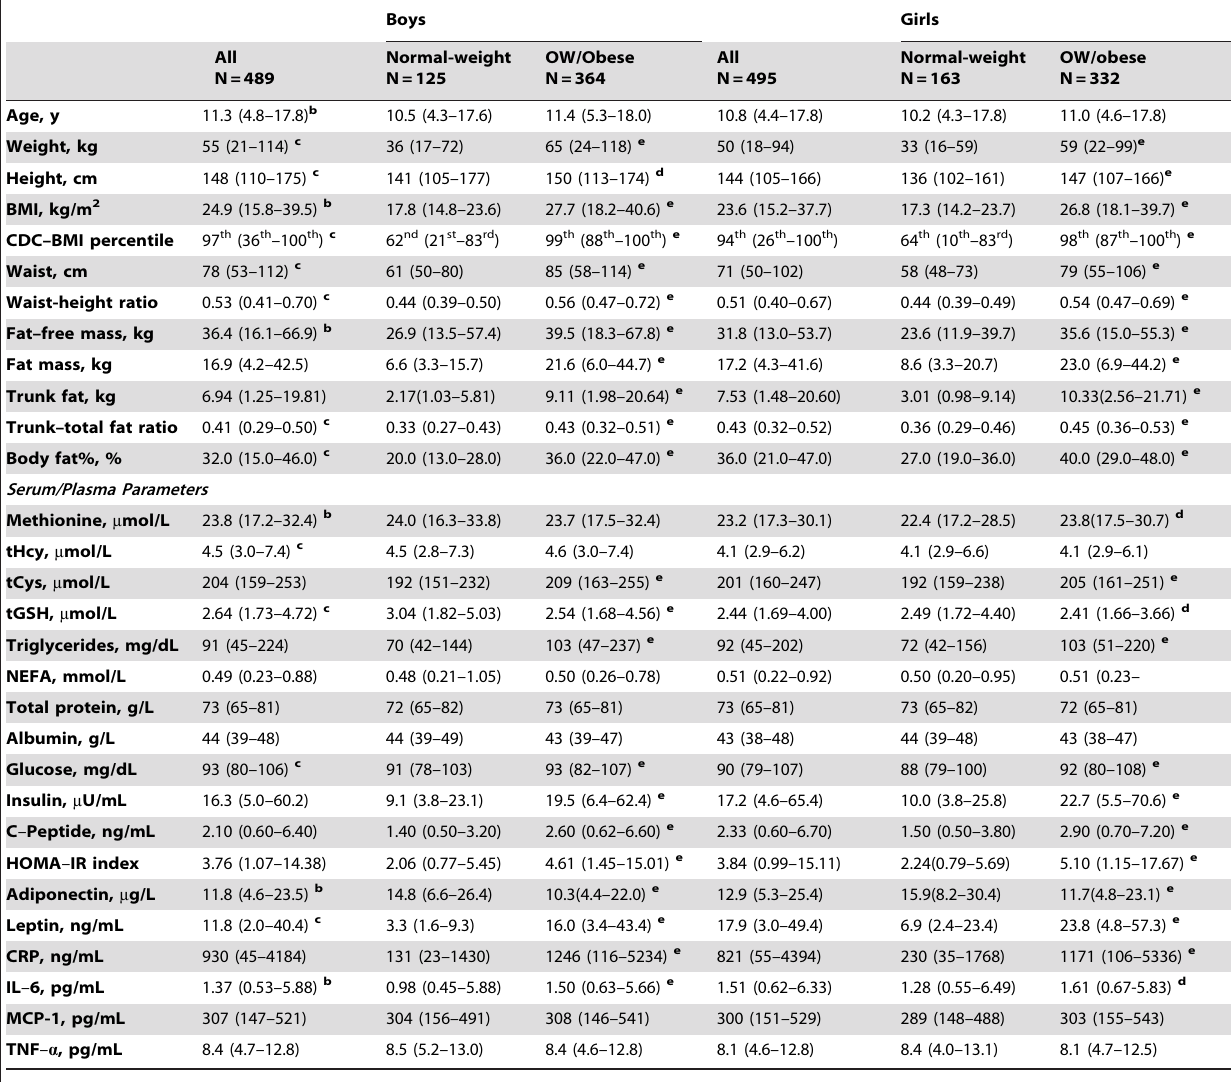
Table 1. Characteristics of the study population.